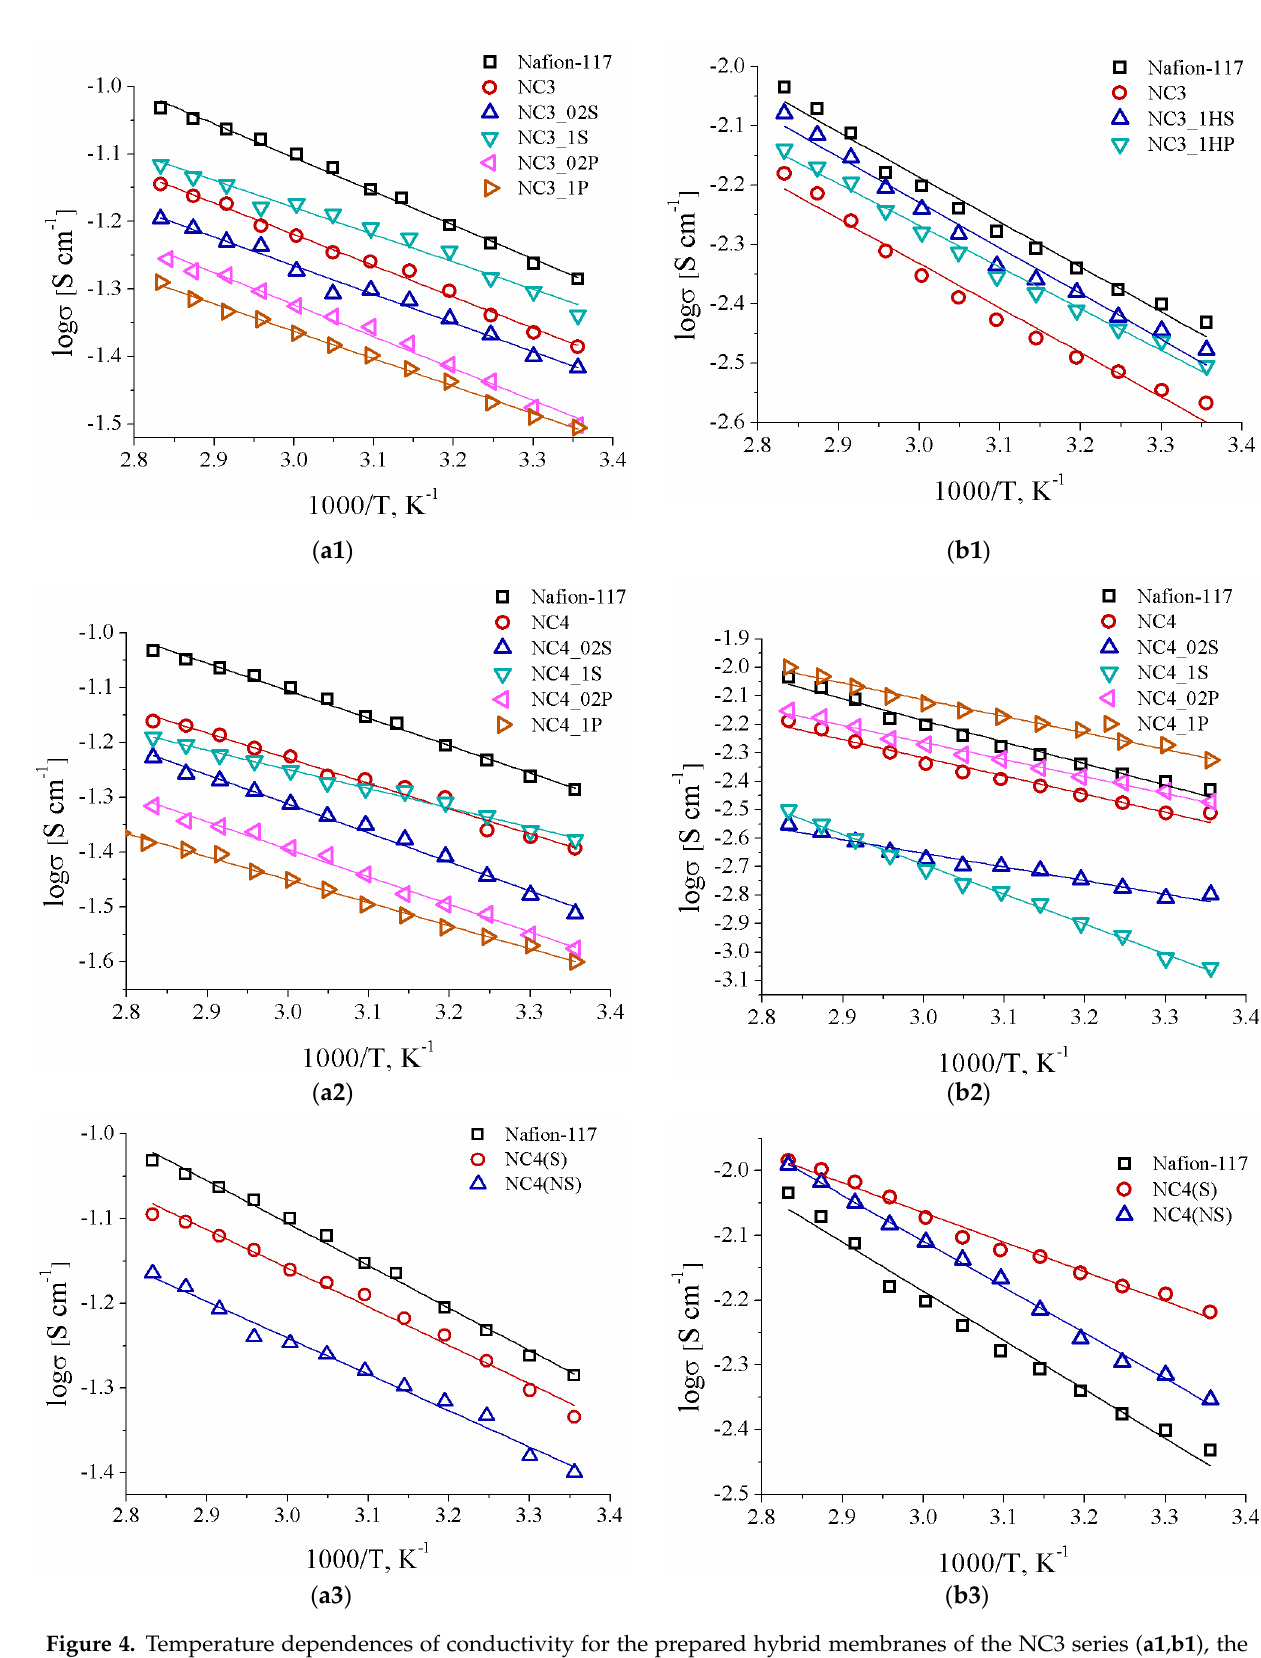
Figure 4. Temperature dependences of conductivity for the prepared hybrid membranes of the NC3 series ( a1 , b1 ), the NC4 series ( a2 , b2 ), the NC4(S) and NC4(NS) membranes ( a3 , b3 ) in contact with water ( a1 – a3 ) and at 30% relative humidity ( b1 – b3 ).